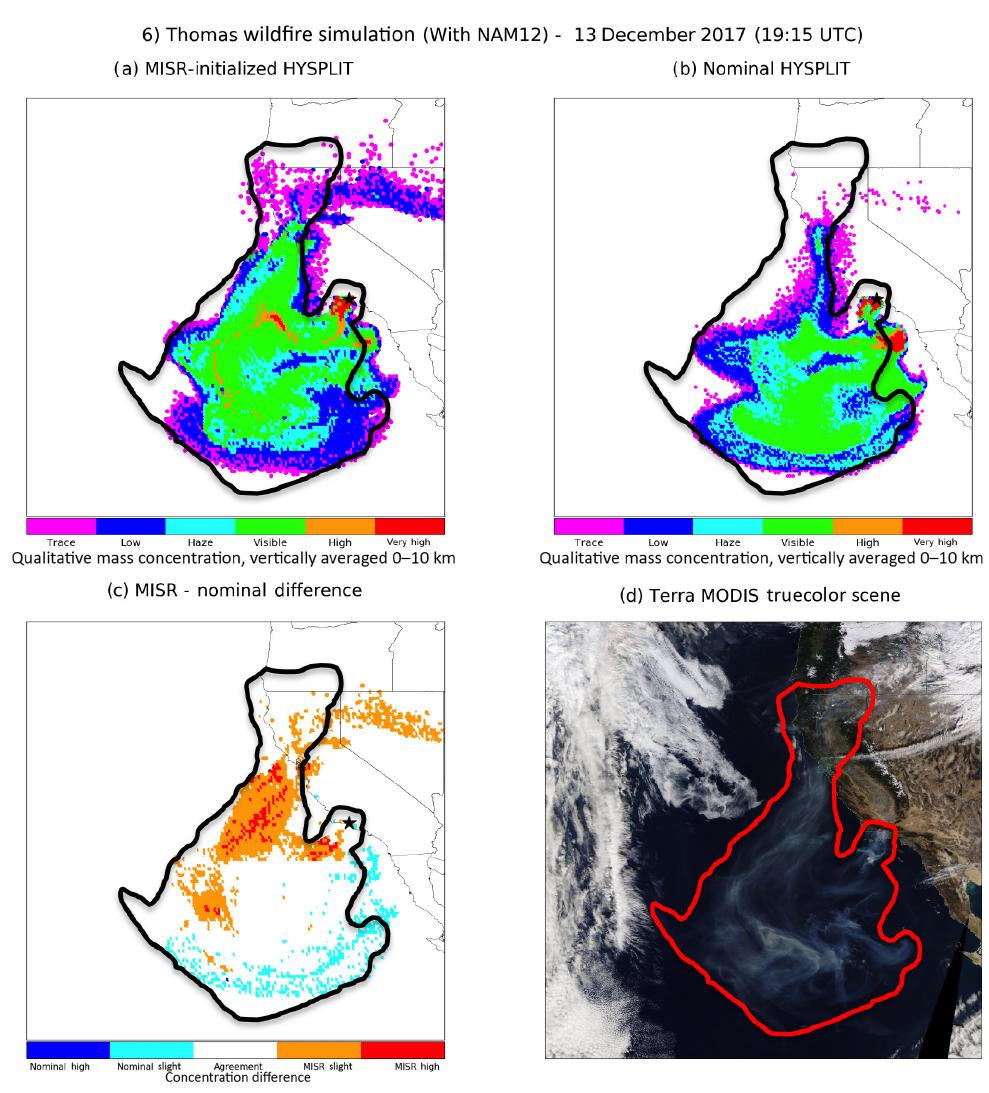
Figure 6. Same as Fig. 2, but for the Thomas fire plume, on 13 December 2017, using NAM12km meteorological data. (a–b) Day 4 samplings of HYSPLIT 96h simulations run with the NAM12 meteorology, beginning on 10 December 2017, and (c) Day 4 difference plot. (d) MODIS true-color image acquired on 13 December